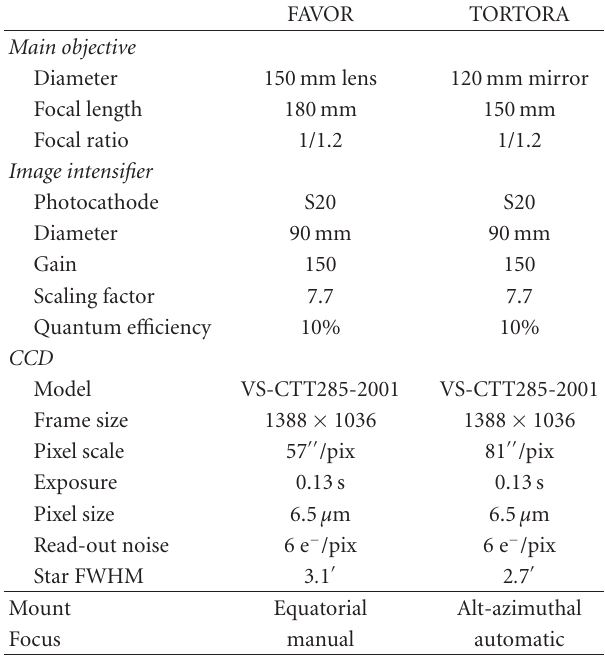
Table 2: Technical parameters of the FAVOR and TORTORA